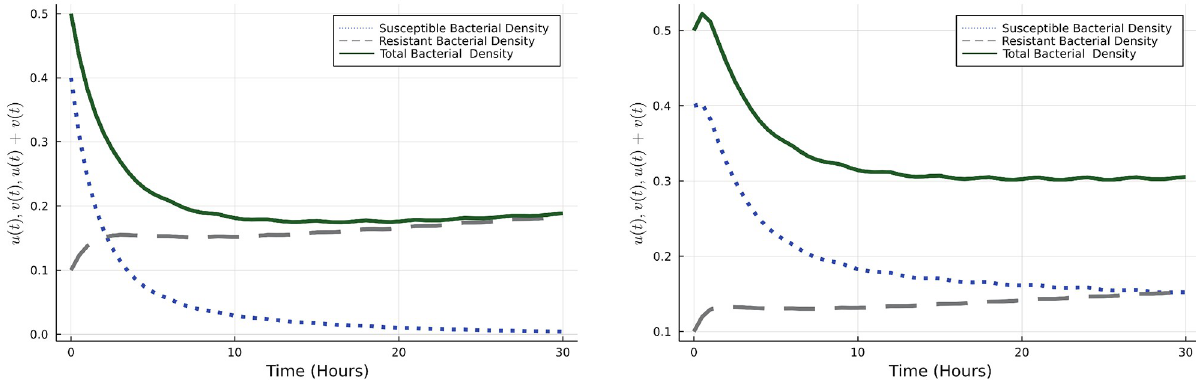
Fig 3. The left figure shows the failure of the antibiotic treatment for 0 < t < 30 h when λ 4 = − 0.0017 < 0 and λ 5 = 0.0821 > 0. The right figure shows the failure of the antibiotic treatment for 0 < t < 30 h when λ 4 = 0.3868, λ 5 = 0.4224 > 0.